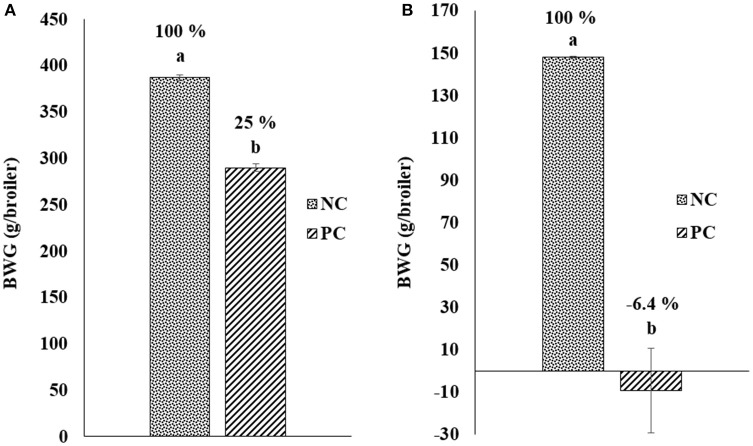
Change in body weight gain (BWG; g/broiler) after challenge with (A)
Eimeria maxima and (B)
Clostridium perfringens in a Necrotic enteritis model.